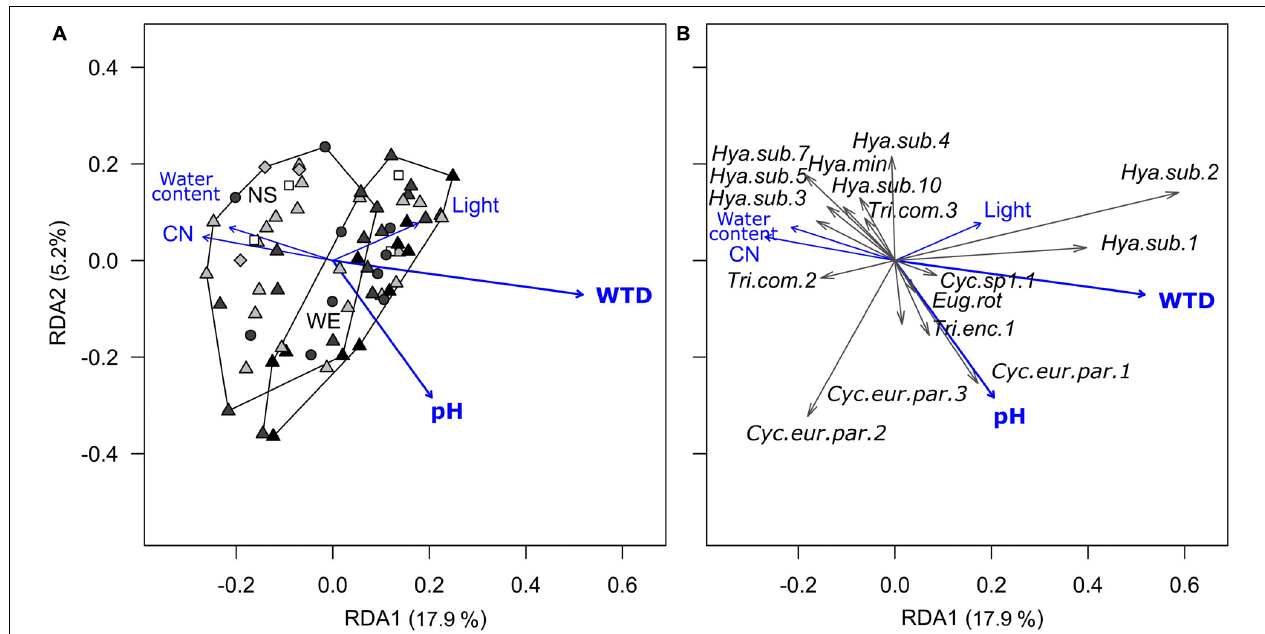
FIGURE 2 | Ordination diagrams based on the result of RDA showing the variation in morphotype composition (unscaled data) of testate amoeba communities in surface samples from the Sungai Buluh peatland in response to environmental variables. (A) Sample scores: the polygons encircle samples from the same transect (NS or WE); symbol colour denotes the microrelief (black – hummock, dark grey – flat, light grey – hollow, white – pool), symbol shape denotes the substrate type (circle – herbal litter, square – pool sediments, diamond – rooted soil, triangles – tree litter). (B) Species scores (only values ≥ |0.04| with at least one of the axes are shown). The number in parentheses is the proportion of the total variance explained by the axis. Significant environmental variables (WTD and pH) are shown in bold. WTD, for water table depth; CN, for C-to-N ratio; Light, for light intensity. For species abbreviations, see Supplementary Table 2 .